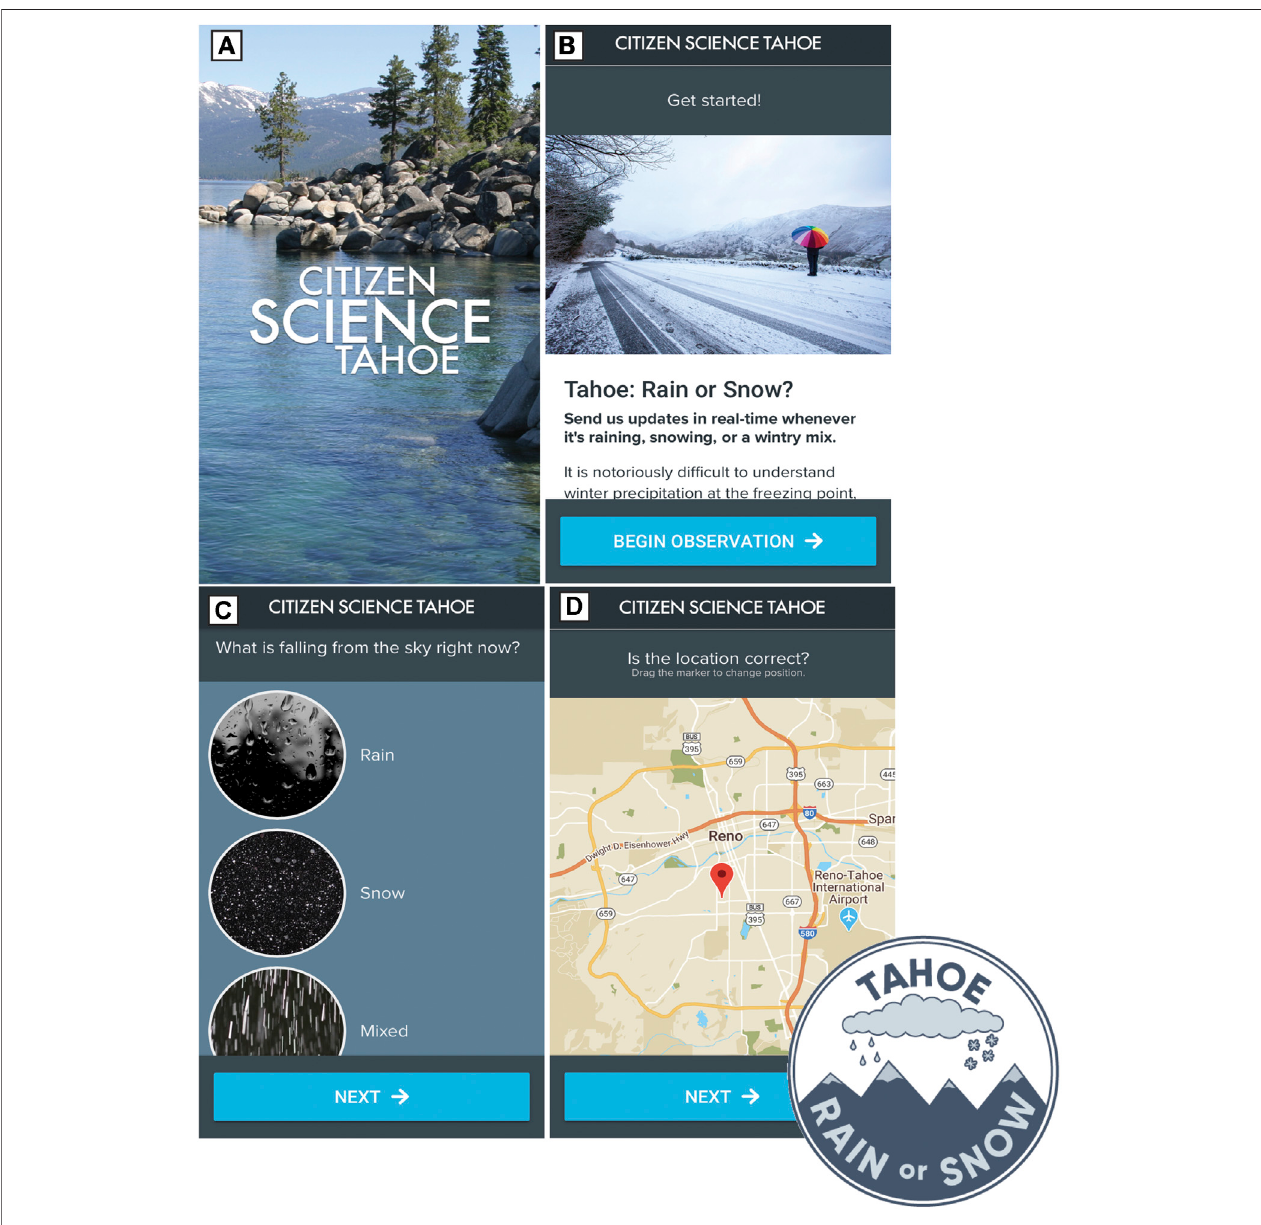
FIGURE 1 | TheTahoeRainorSnowsurveywashostedontheCitizenScienceTahoeapp (A) .Theintroductoryscreen (B) providedbackgroundandtraining.Thefollowing screen the user chooses the precipitation type: Rain, Snow or Mixed (C) . Lastly, the user veri fi es their location (D) and can manually move the location pin if it is incorrect.